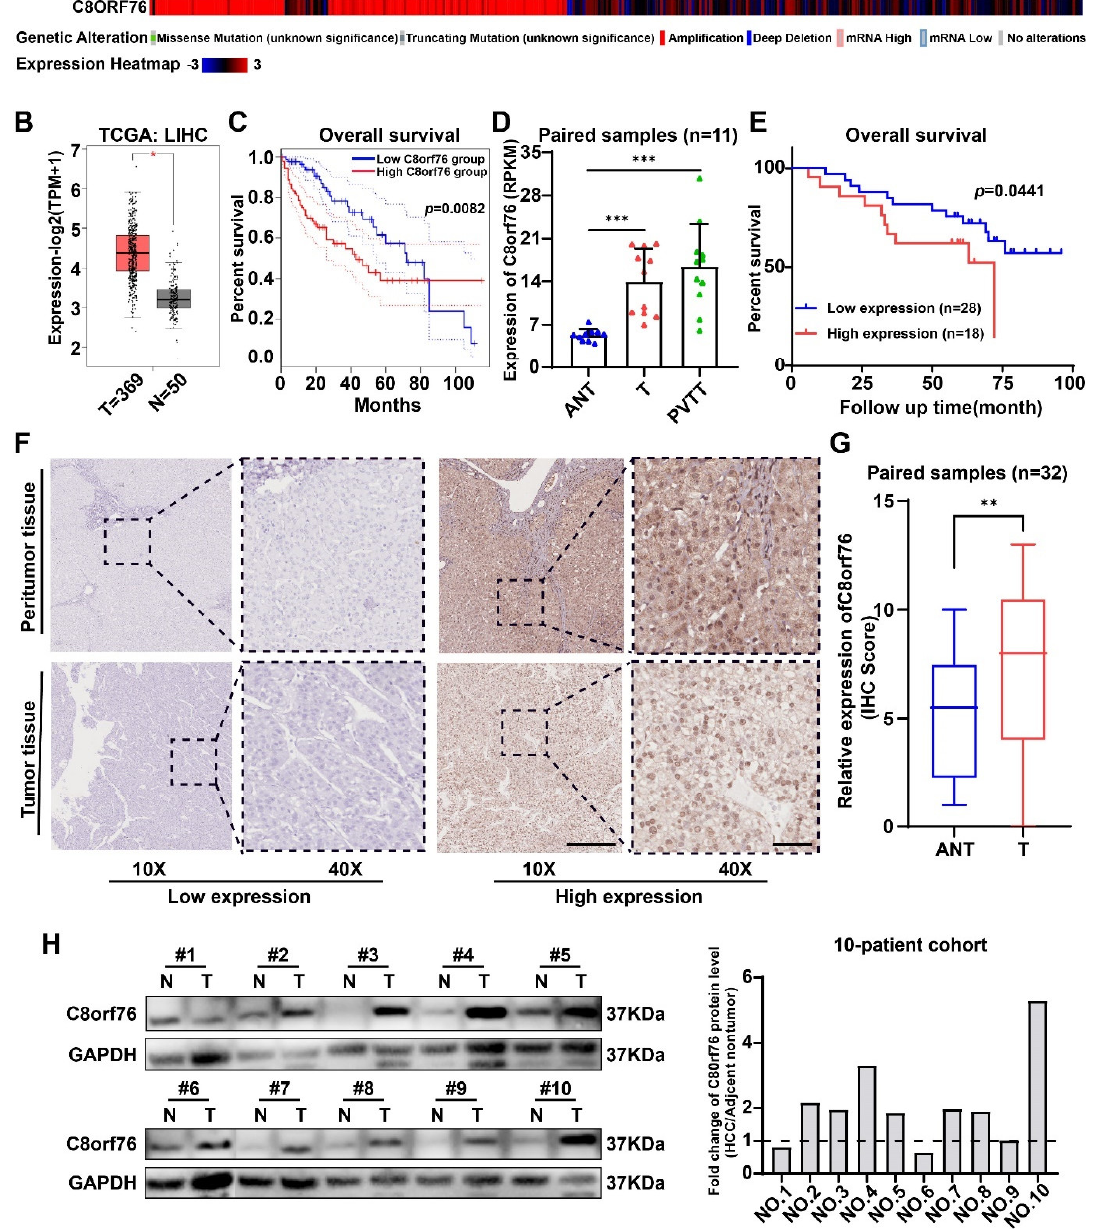
Figure 1. C8orf76 expression is upregulated in HCC tumors and correlates with HCC progression and prognosis. ( A ) The association of C8orf76 DNA copy−number amplification and its mRNA expression in HCC patients of TCGA. ( B ) The mRNA levels of C8orf76 were analyzed in HCC tissues of the TCGA dataset compared to the normal controls. ( C ) Kaplan−Meier analysis of OS for all HCC patients with low or high C8orf76 expression level in TCGA dataset. ( D ) C8orf76 was analyzed in our RNA-seq dataset including 11 paired HCC samples. ( E ) Kaplan − Meier analysis of HCC OS based on C8orf76 protein expression level in HCC tissues (n = 46). ( F ) Representative images of C8orf76 expression in HCC and adjacent tissues. ( G ) The evaluation of C8orf76 expression by performing an IHC staining analysis of 32 paired HCC tissue samples. Scale bars represent 250 µ m (left) and 50 µ m (right). ( H ) Protein expression of C8orf76 in HCC and matched noncancerous tissues through western blot analysis. Data were presented as mean ± SD. * p < 0.05; ** p < 0.01; *** p < 0.001; ns, not significant. T, tumor, ANT, adjacent nontumor, PVTT, portal vein tumor